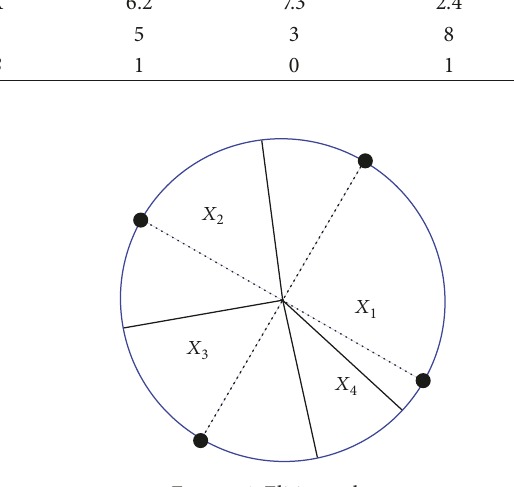
Figure 4: Elitist